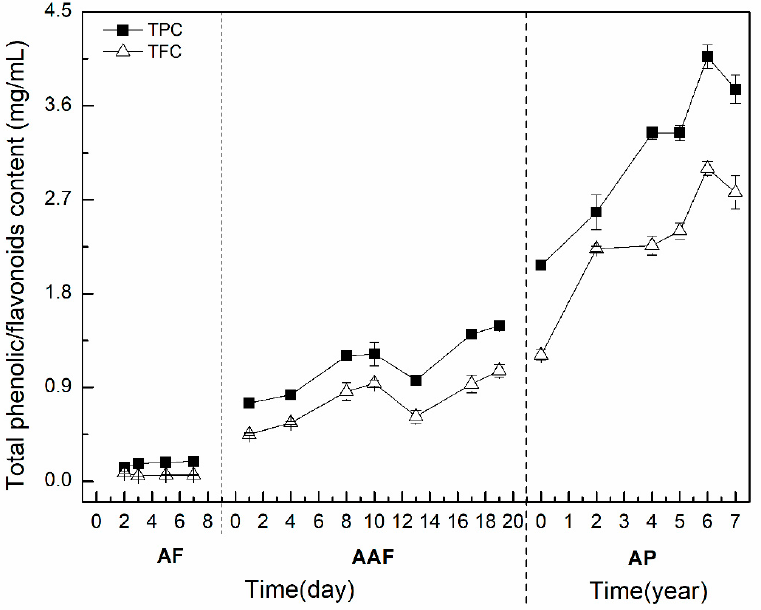
Figure 2. Alteration of TPC and TFC during the brewing process of ZAV. AF: alcohol fermentation, AAF: acetic acid fermentation, AP: aging process, TPC: total phenolic content, TFC: total